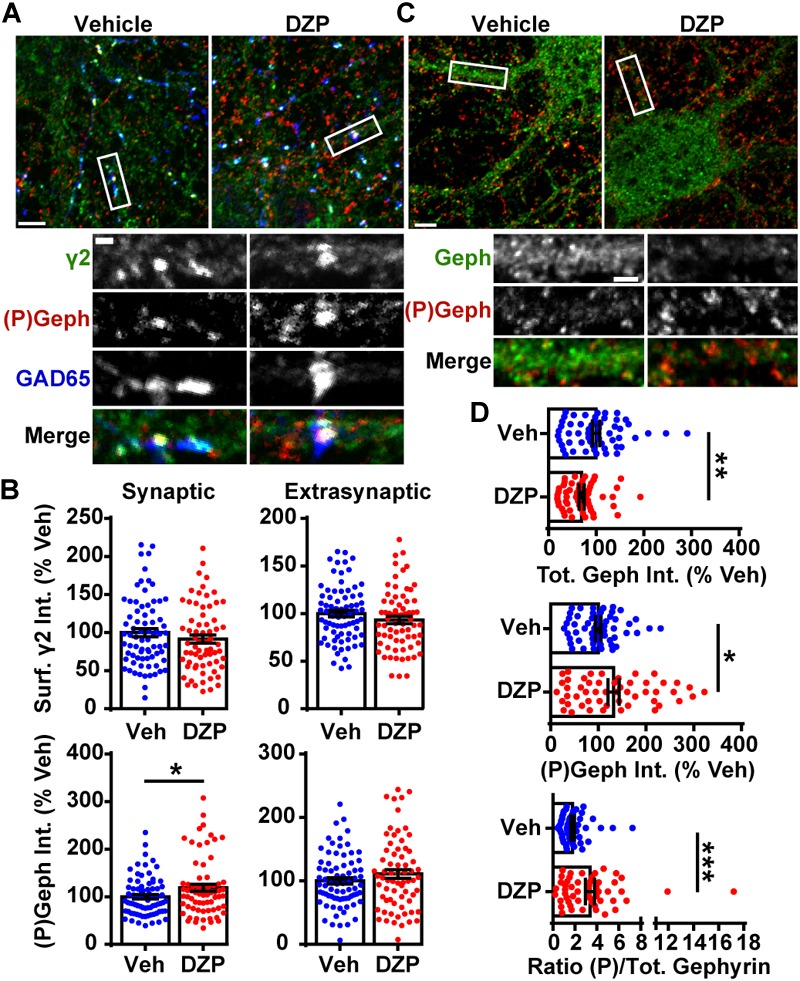
DZP downregulates gephyrin independent of γ2 surface levels. (A) Cortical neurons were treated for 24 h with vehicle or 1 μM DZP, then immunostained for surface γ2 GABAAR (green), followed by permeabilization and immunostaining for (P)Ser270 gephyrin (red), and GAD65 (blue). Panels below show enlargements of GABAAR synapses on dendrites. (B) Dendrite surface synaptic and extrasynaptic γ2 levels are not significantly altered by DZP. Synaptic phospho-gephyrin was enhanced in response to DZP (n = 69–74 neurons; 4 independent cultures). (C) Neurons were treated as in (A) followed by antibody staining for total gephyrin (green) and (P)Ser270 gephyrin (red). Panels below show enlargements of dendrite region. (D) The dendritic pool of gephyrin was decreased, while (P)Ser270 gephyrin levels were augmented, resulting in a dramatic increase in the ratio of phosphorylated gephyrin to total gephyrin (n = 52–59 neurons; 3 independent cultures). Int., fluorescence intensity. Image scale bars: main panels = 5 μm, enlargements = 1 μm. ∗p ≤ 0.05, ∗∗p < 0.01, ∗∗∗p < 0.001, Student’s t-test; error bars ± s.e.m.